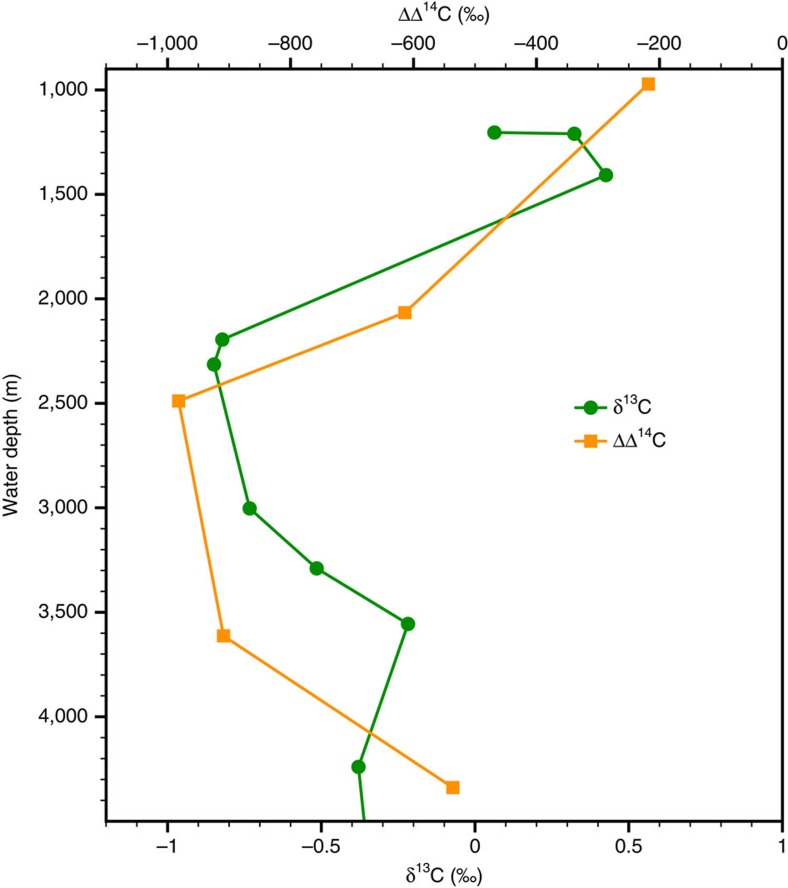
Vertical distribution of carbon isotopes off New Zealand throughout the
LGM.Orange line—ΔΔ14C (this study). Green line
δ13CUvigerina27.